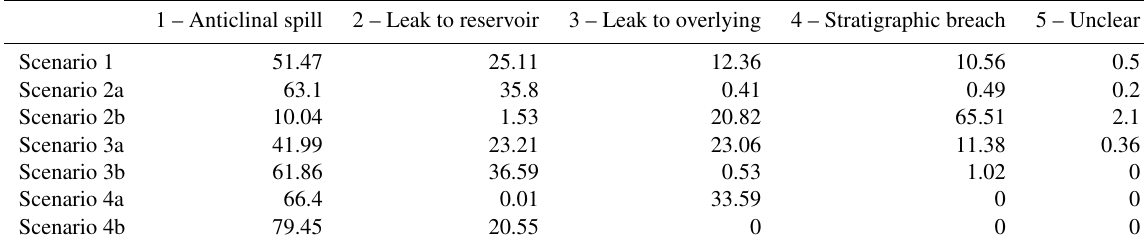
Table B2. Occurrence rate of trap control mechanisms in percent for each information